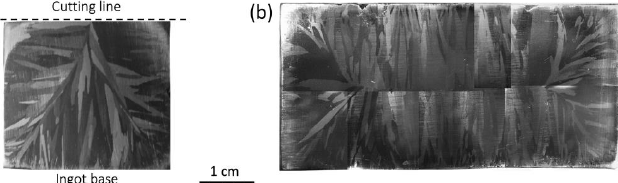
Figure 2. As-cast macrostructures of the prismatic ingot. ( a ) longitudinal section, ( b ) transversal section (details of the ingot sectioning in Figure 1a).